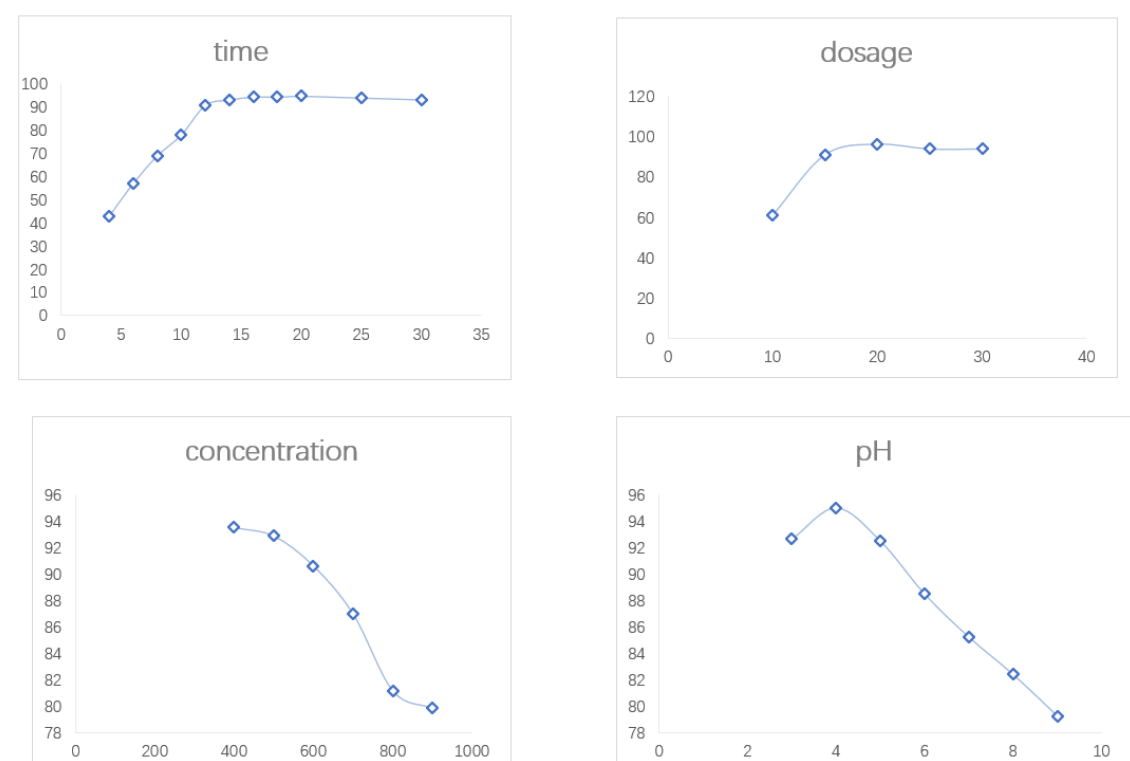
Figure 29. The single-factor experimental curve of binary dyes.